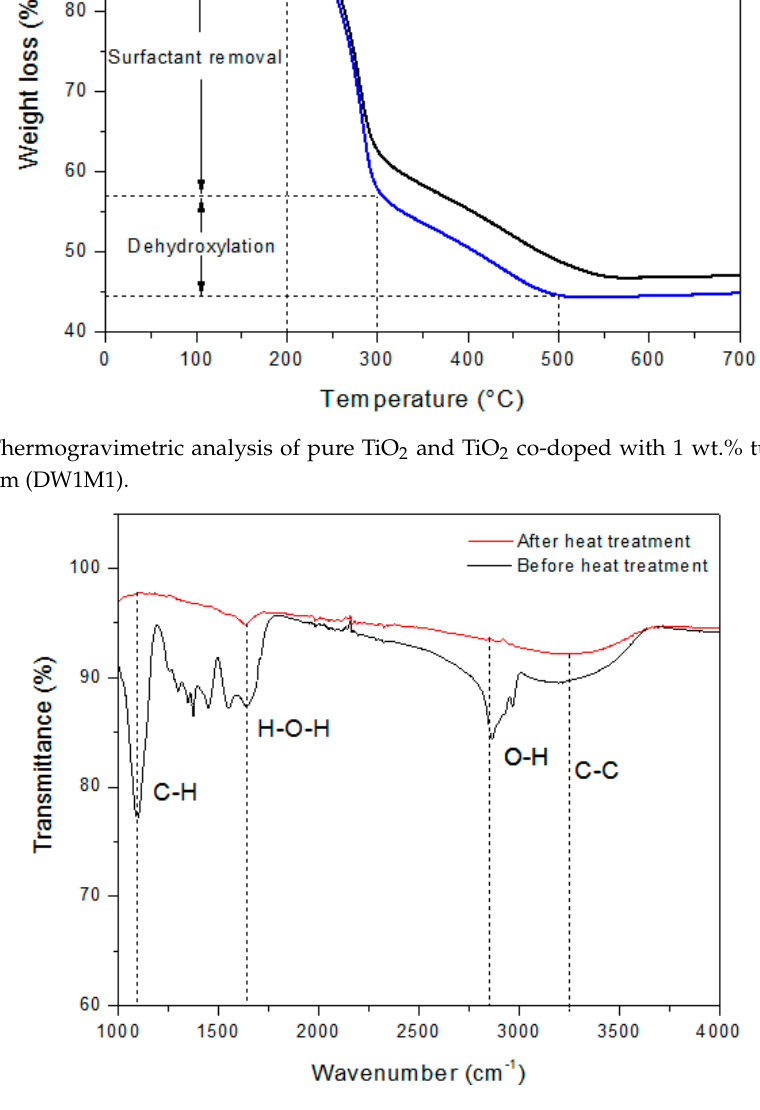
Figure 2. Infrared spectra of pure TiO 2 sample before and after thermal treatment.